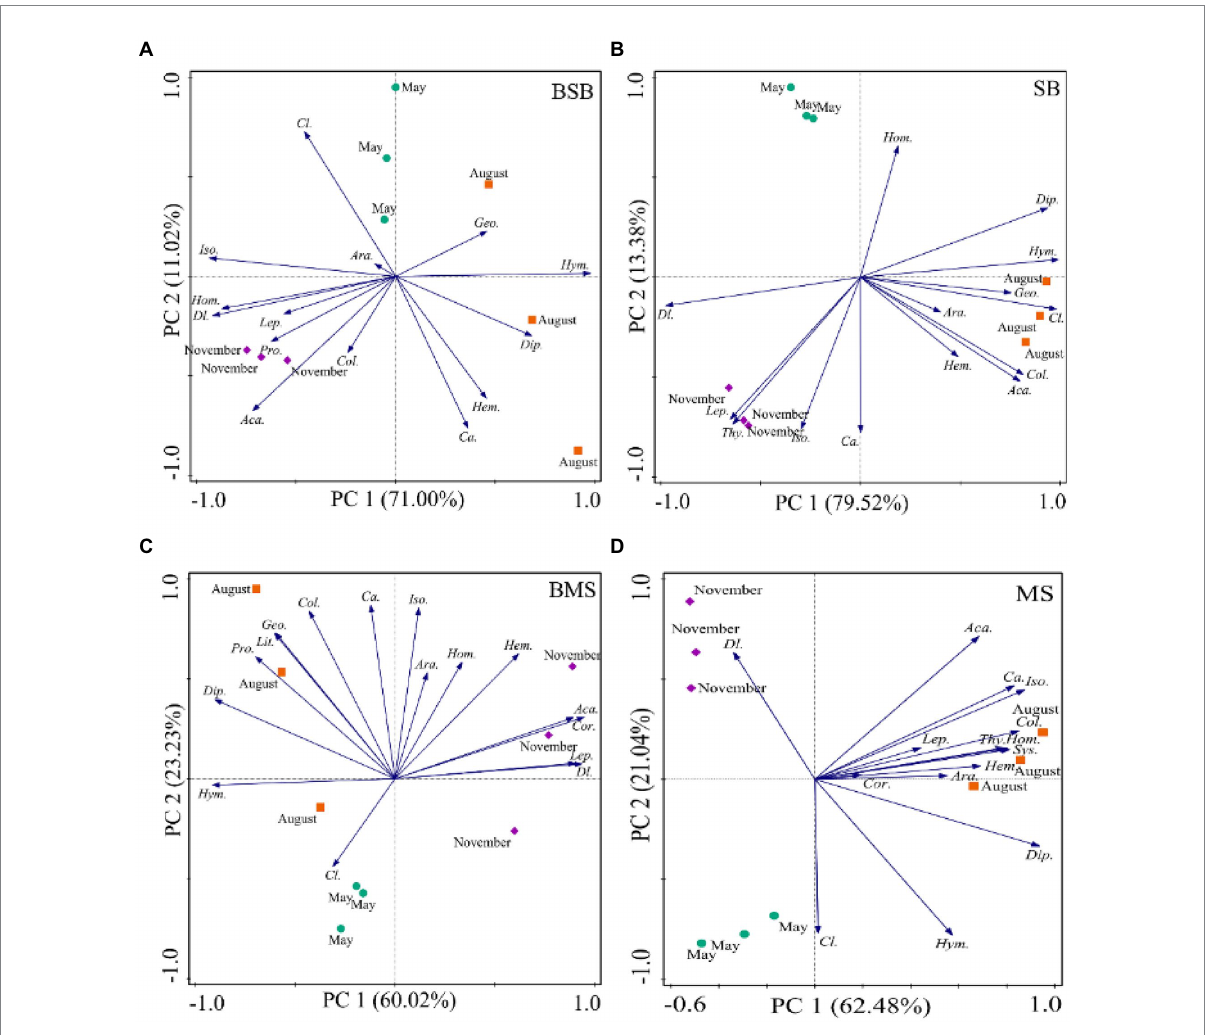
FIGURE 5 Principal component analyses of the temporal dynamics in the community structure of the soil arthropods in BSB (A) , SB (B) , BMS (C) , and MS (D) . Ara., Araneae; Aca., Acari; Geo., Geophilomorpha; Lit., Lithobiomorpha; Sys., Sysmphyla; Pro., Protura; Col., Collembola; Dip., Diplura; Iso., Isoptera; Hem., Hemiptera; Cor., Corrodentia; Thy., Thysanoptera; Cl., Coleoptera larvae; Ca., Coleoptera adult; Lep., Lepidoptera larvae; Dl., Diptera larvae; Hym., Hymenoptera; Hom., Homoptera; SB, Stipa bungeana habitat; BSB, Burned Stipa bungeana habitat; MS, Medicago sativa habitat; BMS, Burned Medicago sativa